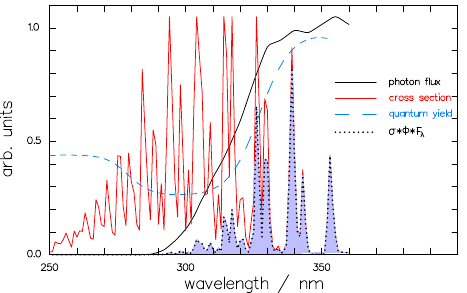
Figure 4. Spectra of the actinic photon flux density (WMO, 1985), the optical absorption cross section (Gratien et al., 2007) and (cid:56) mol at 30km altitude, 33 ◦ solar zenith angle and 227K. The shaded area represents the integrand σ · (cid:56) · F λ of Eq. (8).